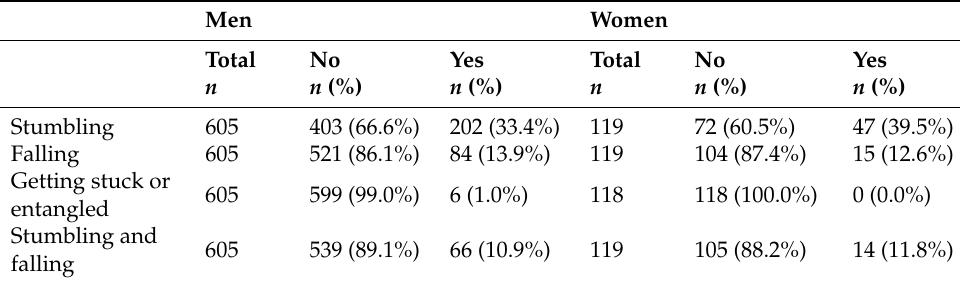
Table 2. Distribution of outcome grouped according to